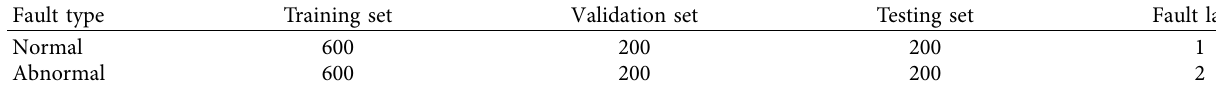
Table 7: Description of loudspeaker pure-tone detection dataset.